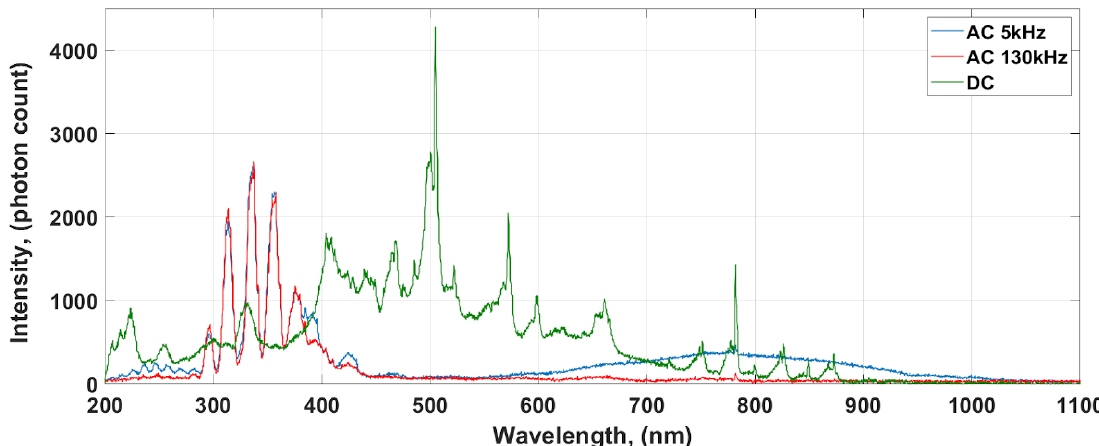
Figure 5. Comparison of spectral characteristics for an electric arc generated in the air at a voltage 4 kV of: 5 kHz AC, 130 kHz AC and DC.